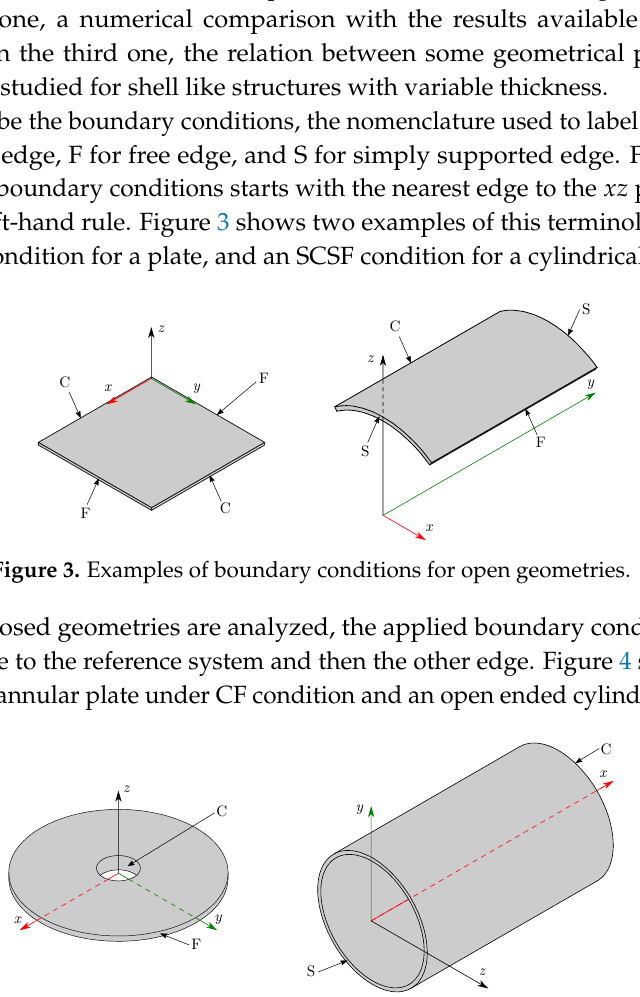
Figure 4. Examples of boundary conditions for closed